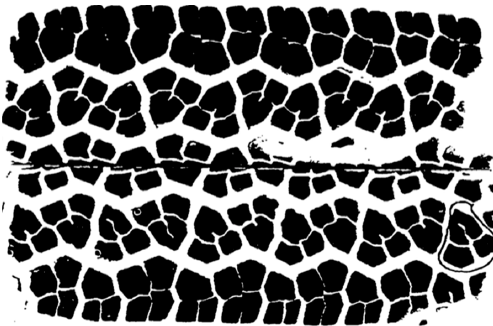
Figure 16. Footprint of old Uniroyal SRTT (4410 N in load, 19 cm in length, 13 cm in width) (source from Ruhala, 1999 [148], Figure 5.2; reprinted with permission from Dr. Richard J. Ruhala of Kennesaw State University). Table 6. Tread element number and length for old SRTT (modified from Ruhala, 1999 [148]). Element